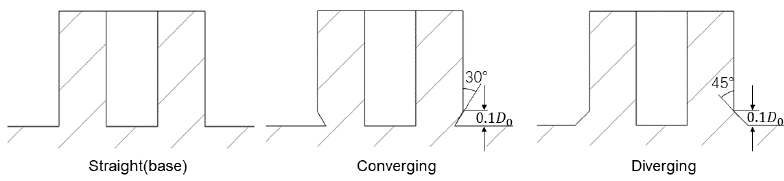
Figure 3. Geometries in the central plane for straight and modified